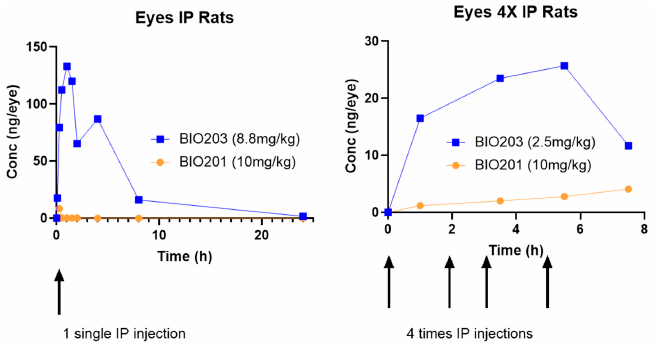
Figure 5. Comparative PK following single or multiple intraperitoneal administrations of BIO203 or norbixin (BIO201). In both experiments, the two eyes from three rats per time point and per group were collected for intraocular concentrations (see material and methods section). 2.3. BIO203 Is Neuroprotective and Preserves the Visual Function of Albino Rats Exposed to Blue-Light-Induced Photoreceptor Degeneration We previously demonstrated that intraperitoneal injections of norbixin at 50 mg/kg was the lowest dose of BIO201 giving the maximal retinal neuroprotection and optimal preservation of visual functions in albino rats exposed to blue-light illumination [4]. To determine whether systemic administration of BIO203 was neuroprotective and could preserve visual function of photoreceptors in vivo, we used the same model of BLD in albino rats. We performed preliminary experiments comparing doses ranging from 0.125 mg/kg to 2.5 mg/kg of BIO203. The tested doses of BIO203 were chosen according to ocular PK data in rats following the same administration protocol used in the BLD studies pre- sented above (Figure 5B). However, in this preliminary experiment, only a limited neuro- protective effect of BIO203 at 2.5 mg/mL compared to vehicle alone was observed. There- fore, we decided to increase the dose of BIO203 from 5 to 25 mg/kg. Increased doses of BIO203 (5, 10, and 25 mg/kg) were injected intraperitoneally at four-time points: 30 min prior to BLD and 1, 2.5, and 4 h after the beginning of exposure to blue- light. The BIO203 effects on visual function and retinal histology at these three doses were compared to the effect of similar regimen administrations of vehicle and positive controls (PBN at 50 mg/kg and the optimal dose of norbixin (BIO201) at 50 mg/kg). Six hours of blue-light exposure induced severe loss of retinal function in vehicle-dosed rats, as measured seven days after exposure by ERG A-wave (Figure 6A) and ERG B-wave (Figure 6B). As previously demonstrated, treatments with PBN and norbixin protected the visual functions [4]. While there was no significant effect in the group treated with 5 and 10 mg/kg of BIO203, four consecutive intraperitoneal administrations of BIO203 at 25 mg/kg provided a protective effect on ERG A-wave and ERG B wave ( p < 0.0001). This protective effect was like those observed in PBN and norbixin-treated animals (Figure 6A,B). We then evaluated the neu- roprotective effect of intraperitoneal injections of BIO203 at 5, 10, and 25 mg/kg. In agree- ment with the effects observed on visual function, treatment with PBN, norbixin (BIO201) at 50 mg/kg, and BIO203 at 25 mg/kg partially preserved the retinal structure of rats sub- jected to 6 h of blue-light exposure ( p < 0.0001) (Figure 6C,D). By contrast, we did not observe neuroprotection following treatment with lower doses of BIO203 at 5 and 10 mg/kg and with vehicle (Figure 6C,D). Altogether we show here that intraperitoneal